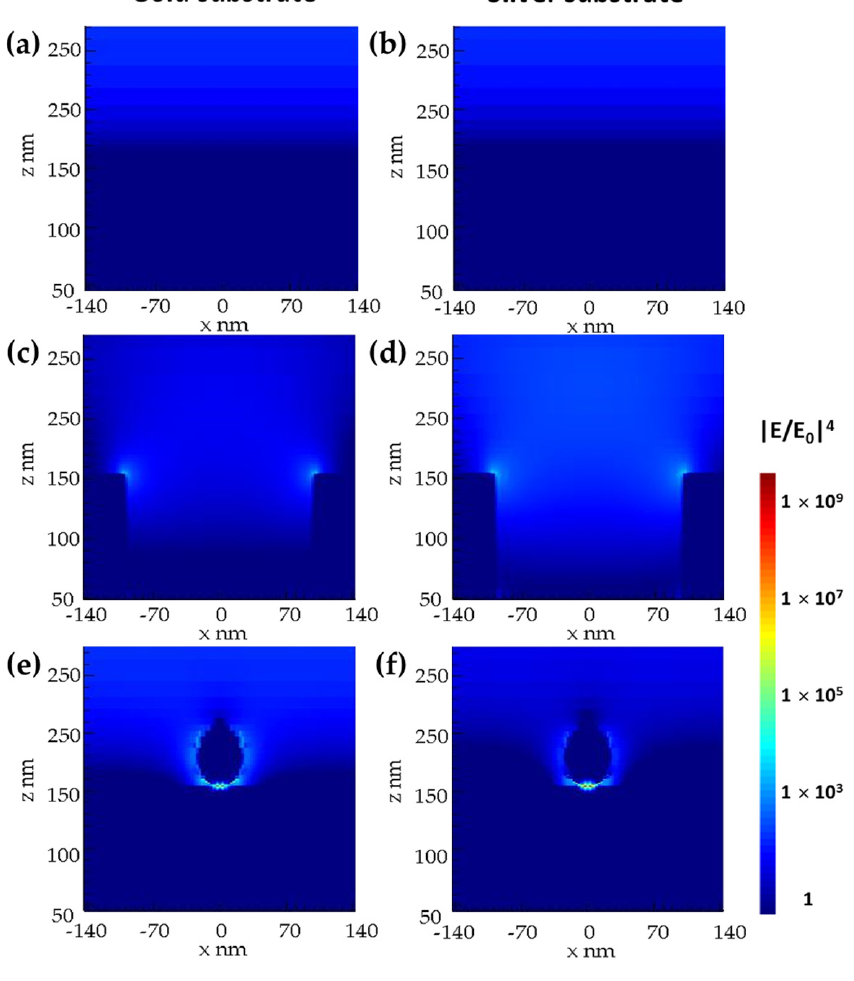
Figure 4. Electric field distribution (| E / E 0 | 4 ) of the electromagnetic Raman enhancement factor for a ( a ) gold and ( b ) silver flat slabs, ( c ) gold and ( d ) silver nanohole arrays, and Ag-NP on ( e ) gold and ( f ) silver slabs.